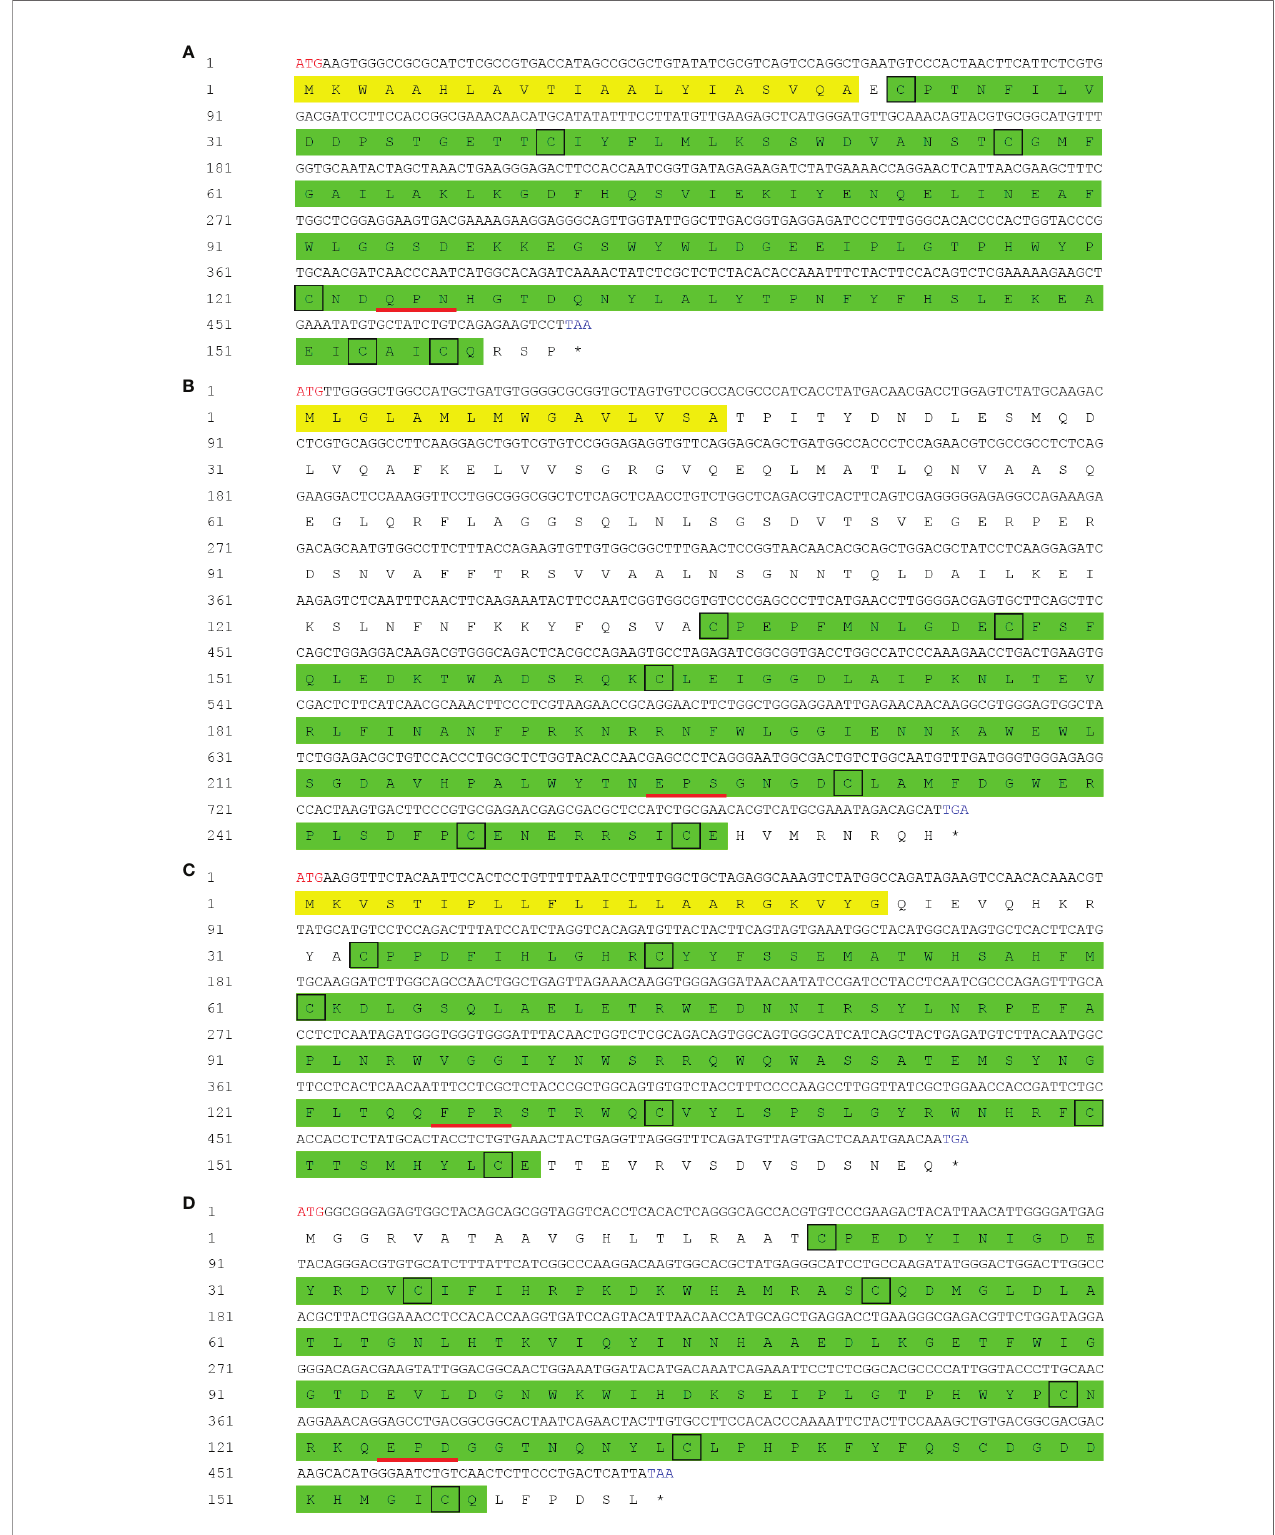
FIGURE 4 | cDNA and deduced amino acid sequence of PtCTLs . Red letters indicate the start sites and blue letters represent the stop codons. The asterisk indicates the stop codon. The signal peptide is shaded in yellow and the CRD is highlighted in green. Highly conserved cysteine residues are shown by black boxes. The carbohydrate binding motif is underlined in red. (A) PtCTL-1; (B) PtCTL-2; (C) PtCTL-3; (D)